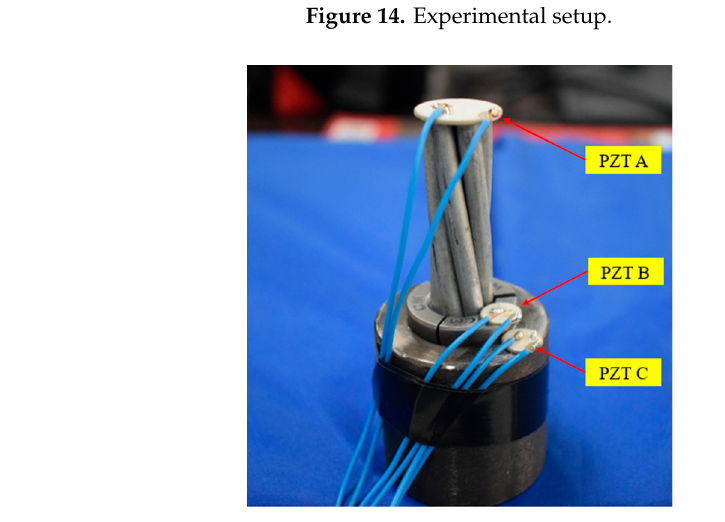
Figure 15. Piezoelectric lead zirconate titanate (PZT) locations of two monitoring techniques.